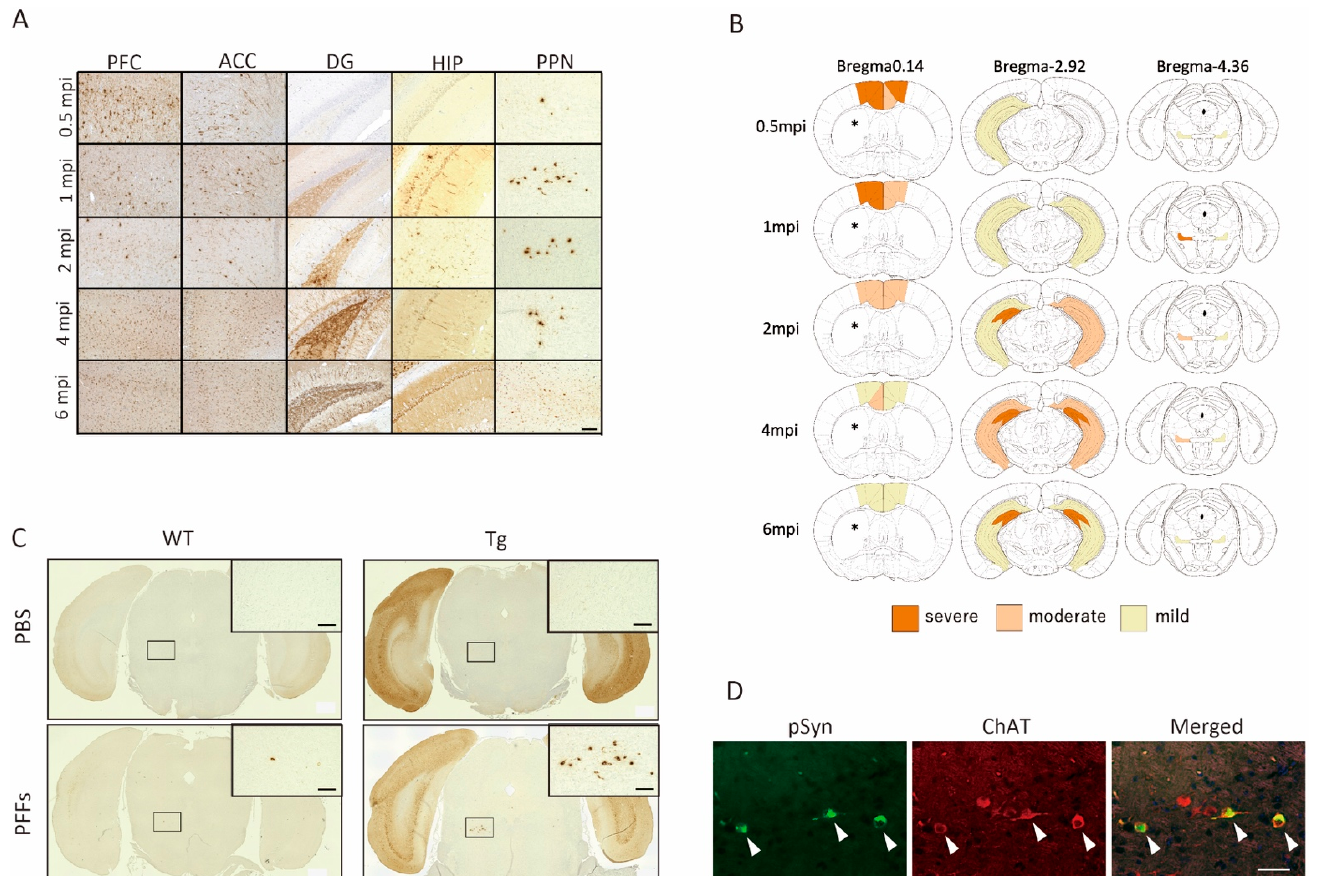
Figure 3. α -syn aggregate pathologies in Tg:PFFs mice. ( A ) P- α -syn immunostaining in various regions of the brain of α -syn PFFs-inoculated SNCA A53T transgenic (Tg) mice (Tg:PFFs mice). PFC: prefrontal cortex, ACC: anterior cingulate cortex, DG: dentate gyrus, HIP: hippocampus, PPN: pedunculopontine nucleus. Scale bar: 100 μ m. ( B ) Heat map of α -syn aggregate pathologies in the Tg:PFFs mice group. * indicates the injection site of α -syn PFFs. ( C ) Phosphorylated α -synuclein (P- α -syn) immunostaining of PPN in wild-type (WT) or SNCA A53T transgenic (Tg) mice at 1-month post inoculation (1 mpi). Each selected frame contains higher magnitude image in the right-upper position. Scale bar: 100 μ m. ( D ) P- α -syn (left panel, green) was co-immunostained with anti-ChAT antibody (second from left panel, red) in the PPN of the Tg:PFFs mice. Arrows indicate the co-immunostained cells. Scale bar: 100 μ m.